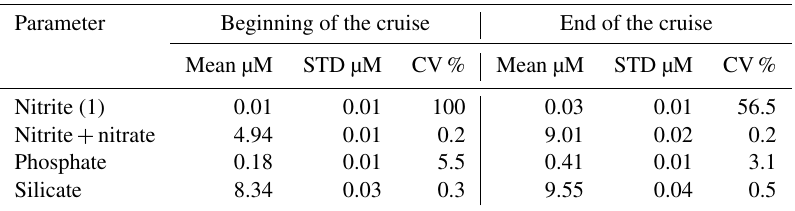
Table 8. Analysis of duplicates.